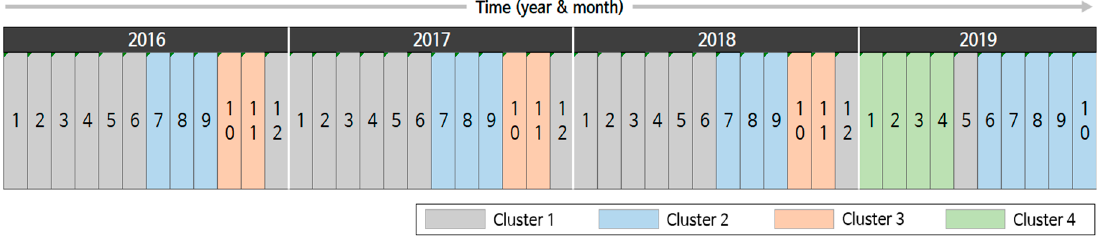
Figure 8. Clustering results by time.